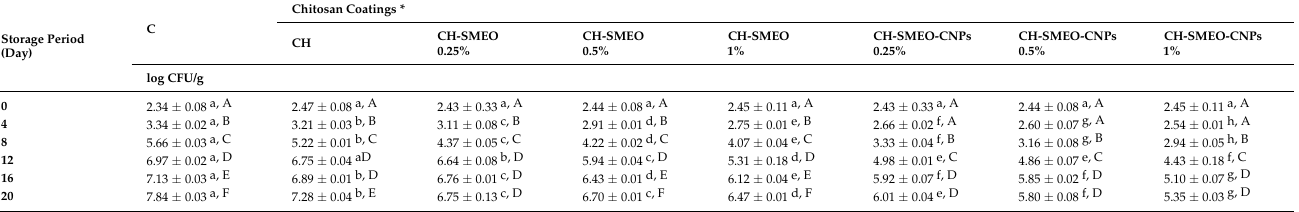
Table 6. Effect of the addition of chitosan coatings and chitosan-based nanoparticles enriched with Satureja montana L. essential oil on the change in the number of psychrophilic bacteria in beef samples during